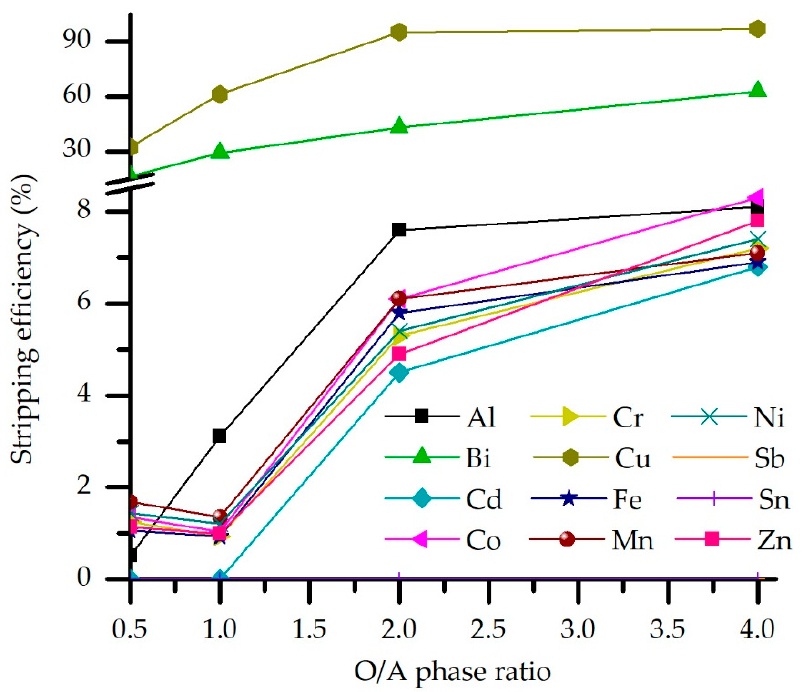
Figure 8. Effect of the phase ratio on the stripping efficiency (M5640 20 vol.% in loaded OP, H 2 SO 4 concentration 180 g/L, temperature 20 °C, and contact time 5 min).